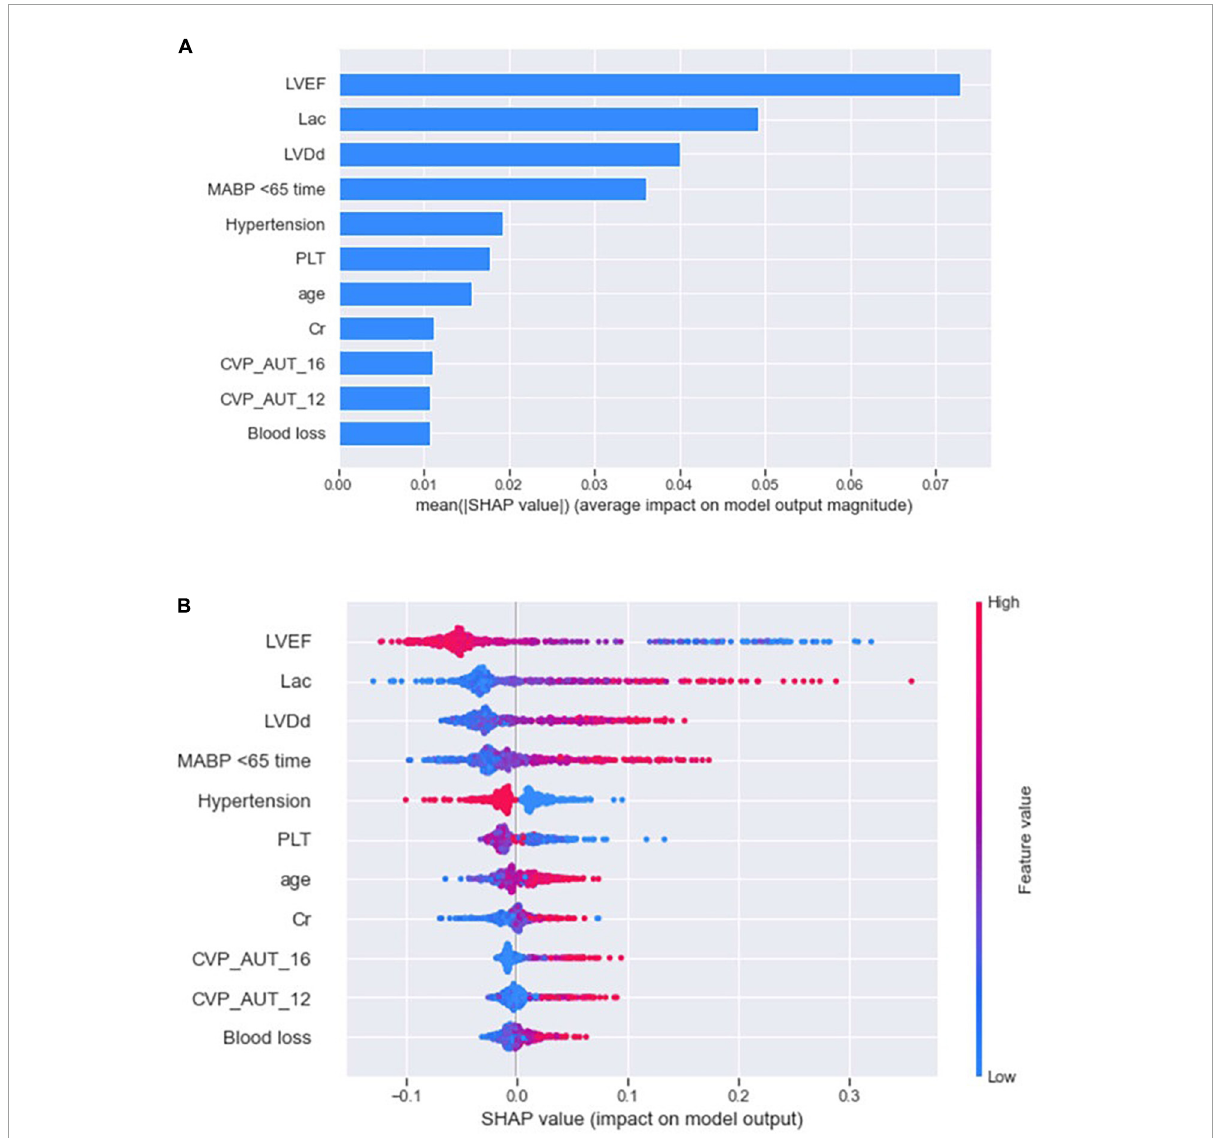
FIGURE3 SHAP summary plot of the reduced RF model. The plot showed the importance of each variable (A) and the specific distribution between variables and Shapely value (B) using SHAP